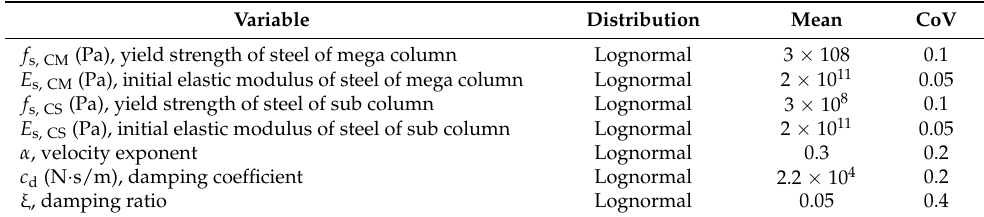
Table 5. Statistical properties of random variables.